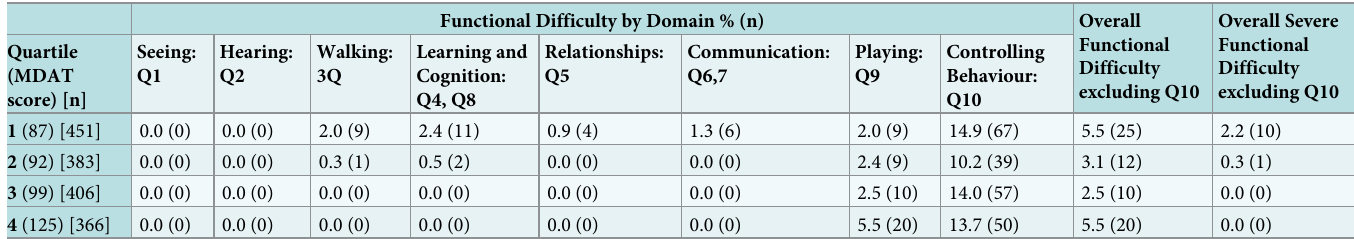
Table 3. Table reporting functional difficulty prevalence by Washington Group Child Functioning Module domain through increasing quartiles of Malawi Devel- opmental Assessment tool (MDAT) score. HIV unexposed infants included only, n = 1606. Functional Difficulty by Domain %